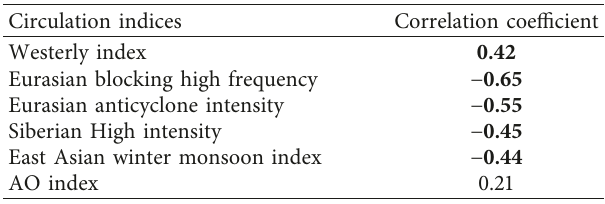
The bold font indicates significance exceeding